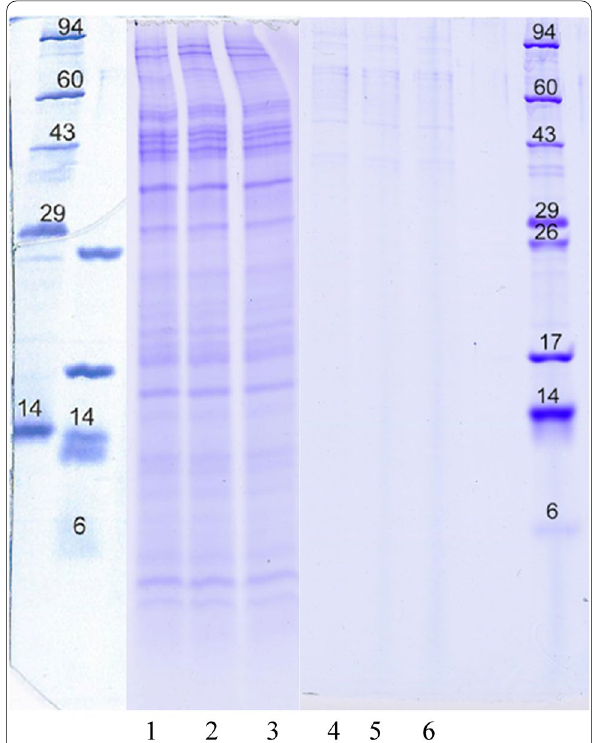
Fig. 1 SDS-PAGE images of the PHs extracted from MDS: 1–3—PH I and 4–6—PH II. The measurements were performed triplicate. The numbers on both sides are the MW markers in KDa for which the following proteins were used as the standards: phosphorylase A (94,000), catalase (60,000), actin (43,000), carbonic anhydrase (29,000), myoglobin (17,000), lysozyme (14,000), aprotonin (6500), insulin chain b